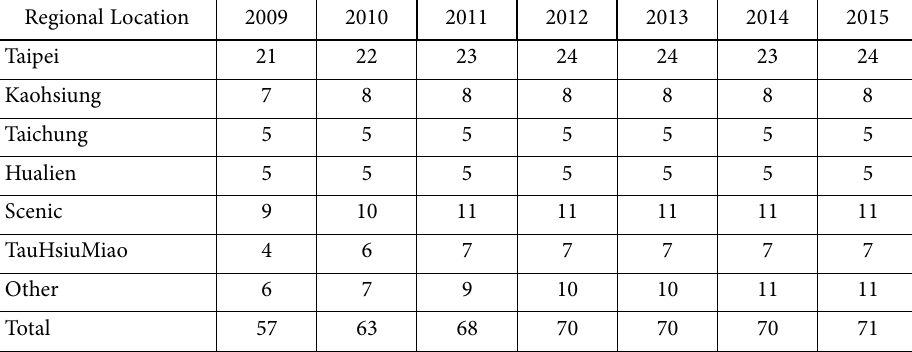
Table 1. The number and regional location of operating Taiwanese international tourist hotels Regional Location